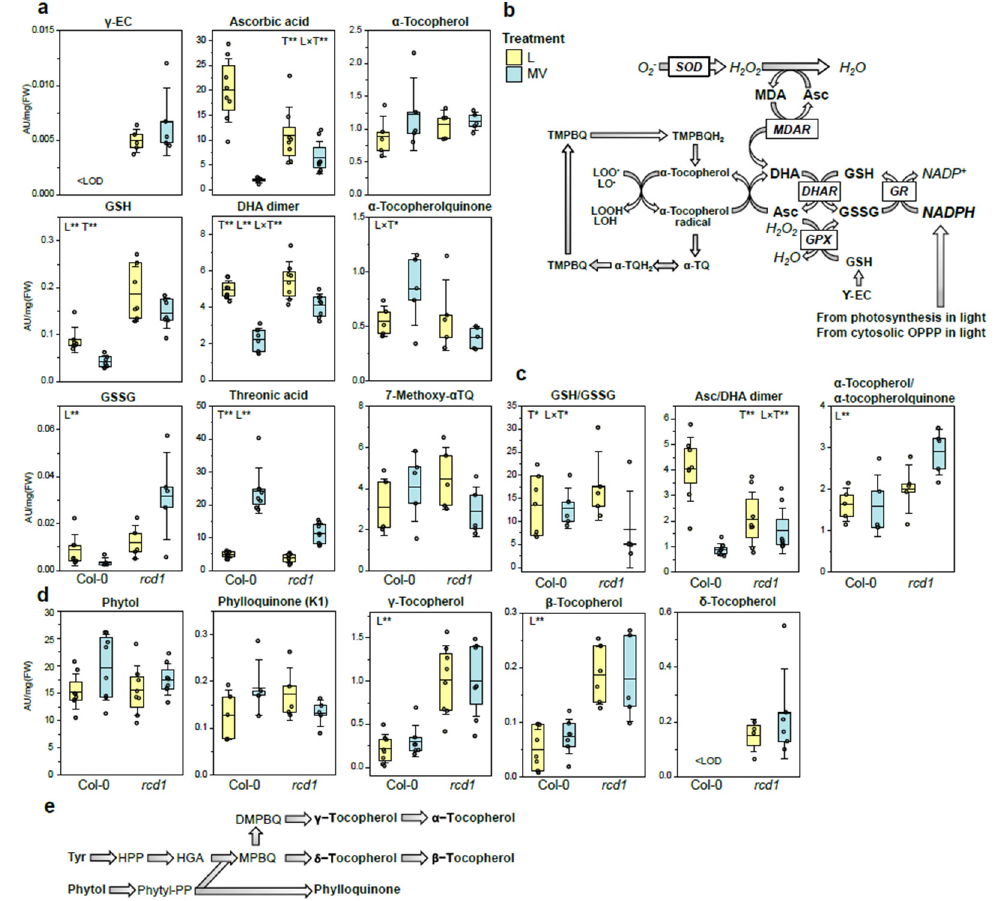
Figure 4. Metabolites involved in tocopherol metabolism and Foyer–Halliwell–Asada redox cycle. ( a ) Glutathione, ascorbate, and -tocopherol metabolite levels (AU/mg[FW]) in Col-0 and rcd1 in control/light conditions (L), and after paraquat exposure (MV) and ( b ) simplified visualization of Foyer–Halliwell–Asada cycle connected to tocopherol redox cycle. ( c ) Ratios between reduced and oxidized metabolite forms. ( d ) Phytol, phylloquinone, and tocopherol levels in Col-0 and rcd1 in control/light conditions (L) and after paraquat exposure (MV) and (e) their biosynthesis pathway. Dots represent data points ( n = 4–8), the box represents 25 and 75 percentiles; the line marks the mean and the whiskers standard deviation. The metabolite levels below limit of detection marked as <LOD. The main effects of plant line (L) and treatment (T) and their interaction (L×T) were tested with two-way ANOVA (FDR-adjusted p -value < 0.05 *, <0.01 **). Tocopherols ( β -, γ -, δ -), phytol, and ascorbic acid metabolite levels were analyzed with GC-MS in Sipari et al. [13] and phylloquinone, glutathione, and α -tocopherol metabolite levels with LC-MS.